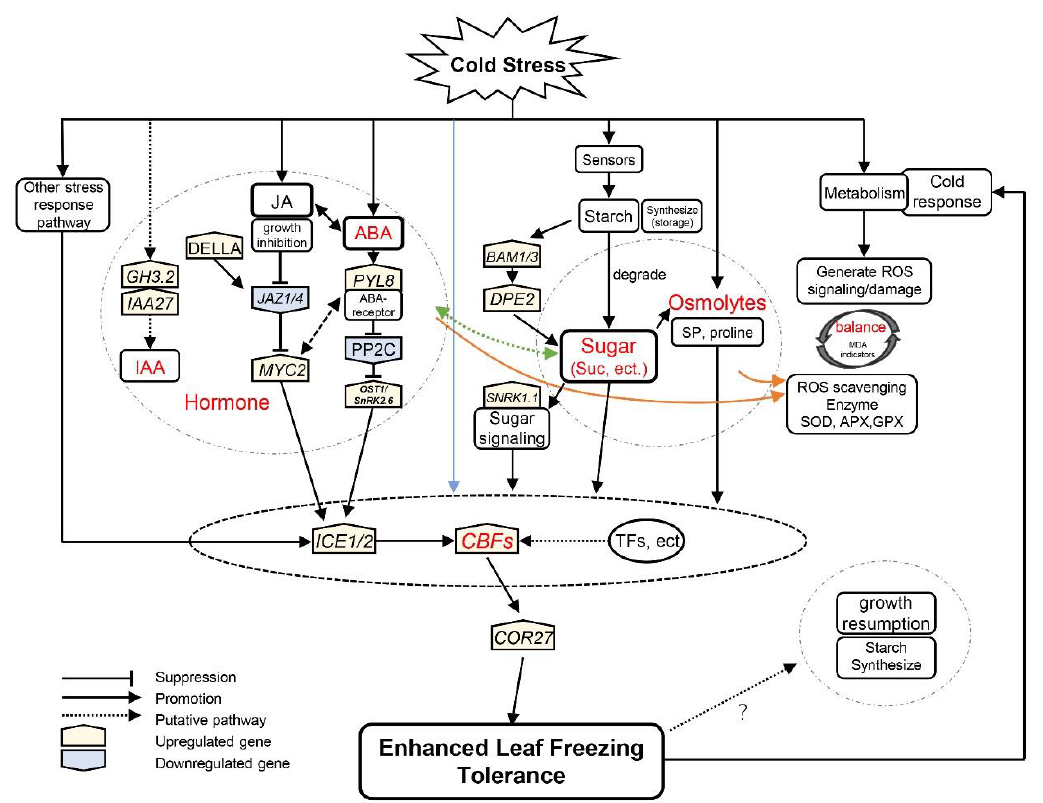
Figure 8. A hypothetical model for iris plants in response to cold stress during winter. Arrows indicate promotion, whereas lines ending with a bar suggest suppression. The blue line indicates that cold signaling partially directly regulates the leaf freezing tolerance of plants through the ICE–CBF– COR cascade. The orange lines indicate phytohormones and sugars that facilitate reactive oxygen species scavenging. The levels of jasmonic acid (JA) were proportional to sucrose concentration in evergreen irises, and the green line indicates a putative pathway. Gene names are shown in Table S2.